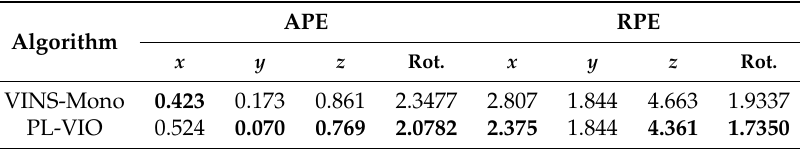
Table 4. The results evaluated by PennCOSYVIO evaluation tool for different algorithms. The rotation errors for the APE and relative pose error (RPE) are expressed in degrees. The translation error is expressed in the x -axis, y -axis, and z -axis. The APE is expressed in meters, while the RPE is expressed in percentages (%). The numbers in bold represent the estimated trajectory is more close to the benchmark